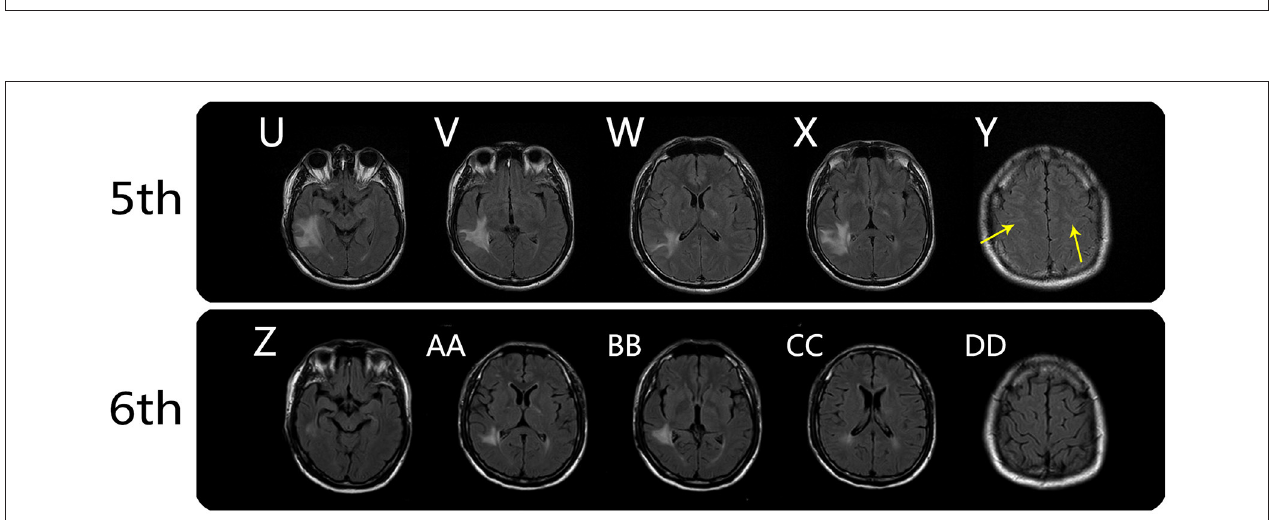
FIGURE 3 | Brain MRI findings from the fifth and sixth MRI scans. Fifth MRI scan (on day 132): axial FLAIR showed persistent meningo-cortical hyperintensity ( Y , arrows) and new lesions around the temporal lobe, posterior limb of internal capsule (right), and left trigone of the lateral ventricle (U–X) . Sixth MRI scan (on day 148): axial FLAIR showed substantial reductions in the original lesions without new lesion formation ( Z , AA , BB , and CC ), and the meningo-cortical FLAIR hyperintensity disappeared (DD) .